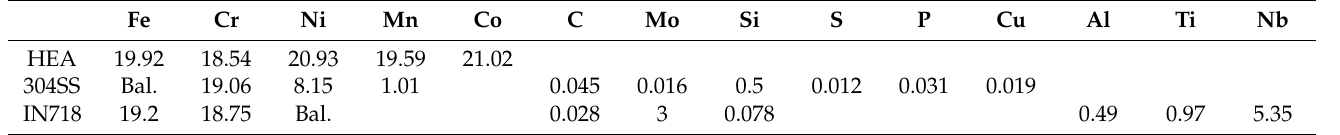
Table 1. Chemical compositions of CoCrFeMnNi HEA, 304SS and IN718 alloy (wt.